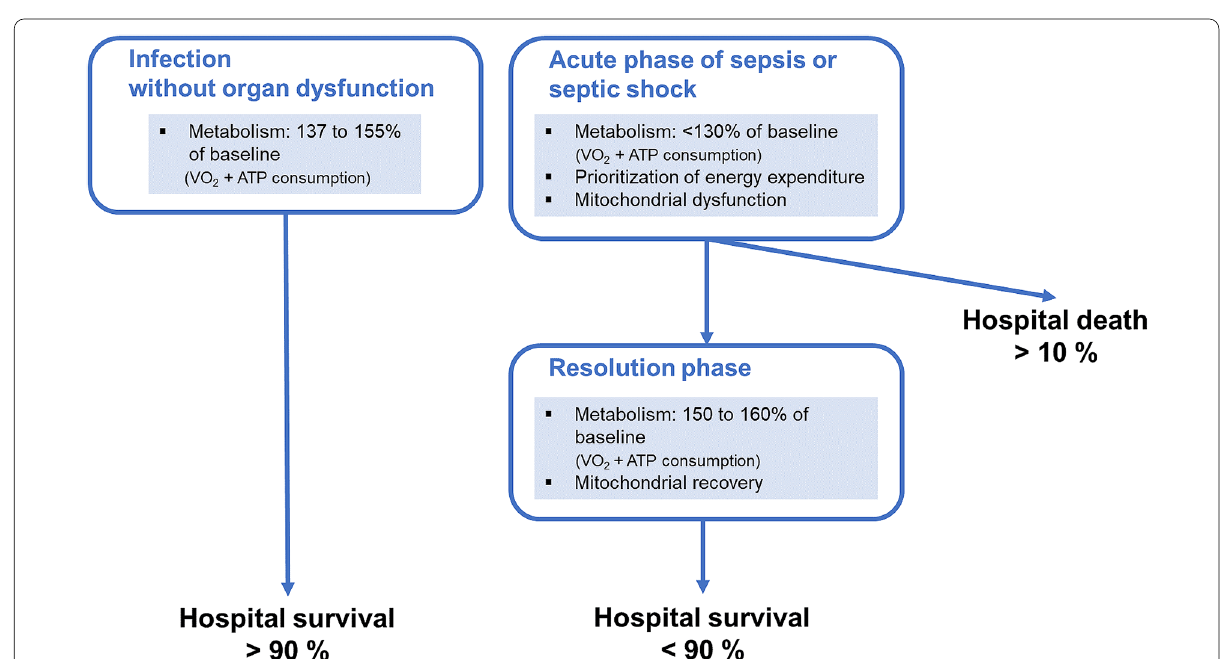
Fig. 1 Different metabolic features of patients hospitalized for infection. ATP adenosine triphosphate, VO 2 oxygen